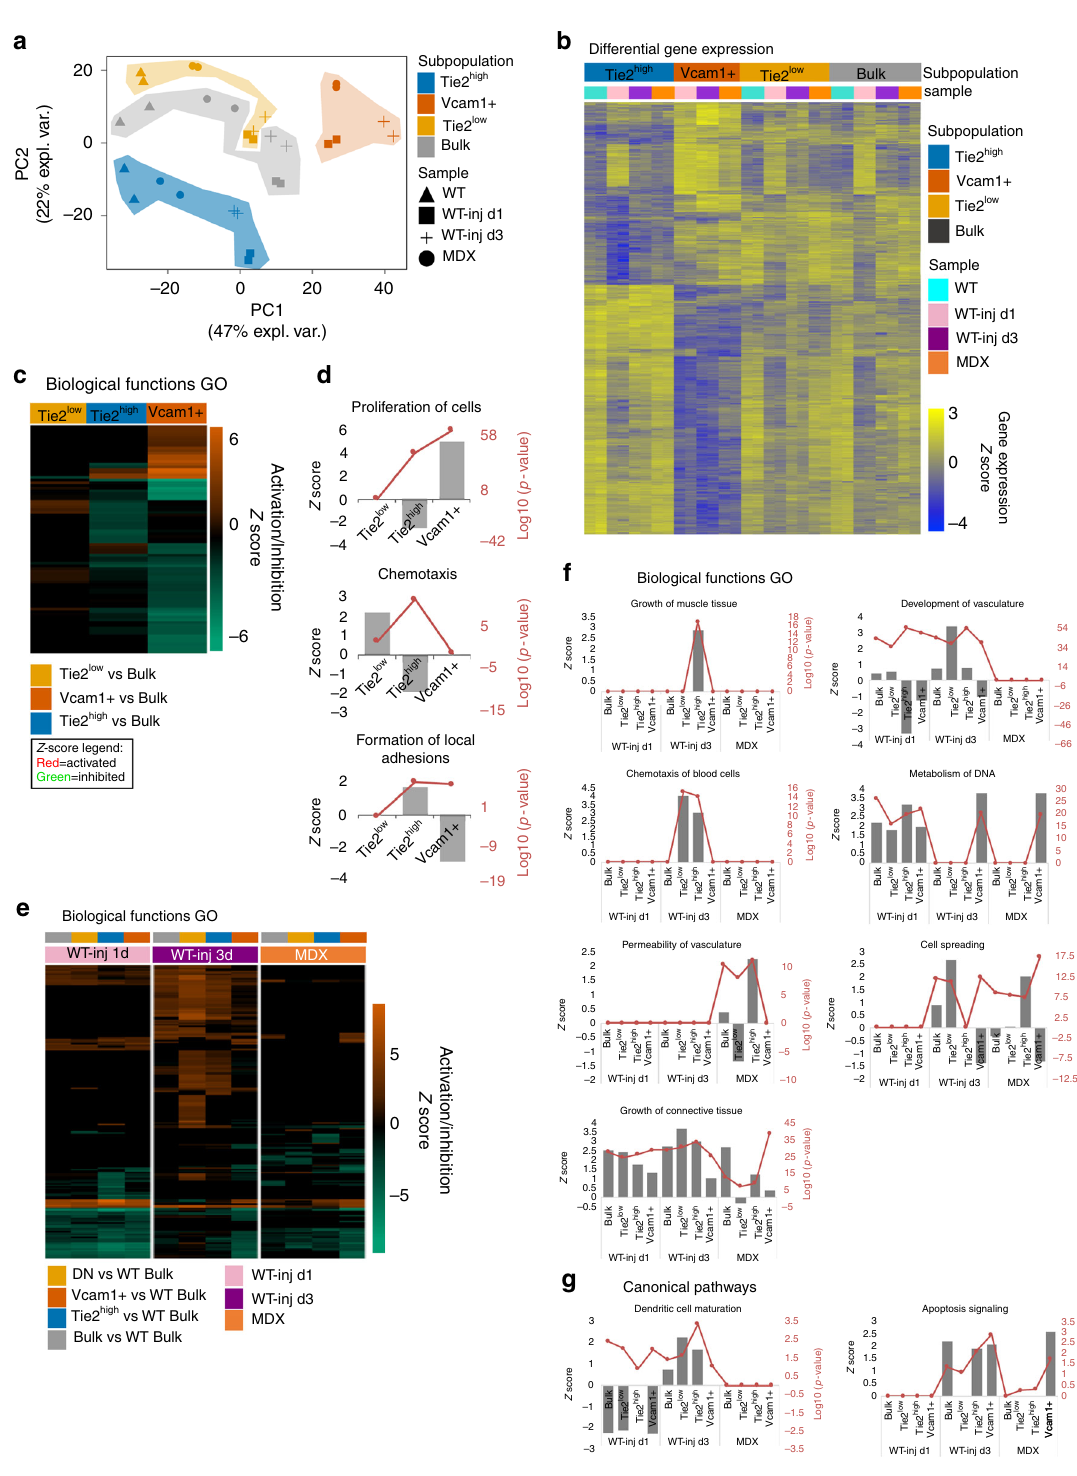
Fig. 3 SubFAPs have unique transcriptional pro fi les that are modulated by injury. a Principal component analysis (PCA) of gene expression data from RNA- seq analysis of FAPs subpopulations isolated from wild type (WT), WT NTX-injured at day 1 and day 3 (WT-inj d1 and d3) and dystrophic mice C57Bl/10 (MDX). b Expression heatmap of genes differentially expressed in FAPs subpopulations (Tie2 high , Tie2 low and Vcam1 + ) compared to bulk FAPs (adjusted p -value <0.001). Gene expression is represented as z -score calculated across the rows. c , d Biological functions predicted to be differentially activated or inhibited in each FAP subpopulation compared to bulk FAPs by IPA comparison analysis. Selected altered functions are shown in d . e , f Biological functions predicted to be differentially activated or inhibited in FAP subpopulations in each treatment condition (WT-inj d1, WT-inj d3 and MDX) compared to bulk WT FAPs by IPA comparison analysis. Selected altered functions are shown in f . g Selected altered canonical pathways in FAP subpopulations in each treatment condition (WT-inj d1, WT-inj d3 and MDX) compared to bulk WT FAPs by IPA comparison analysis. d , f and g Gray bars represent z -score (predicted level of activation/repression of the gene ontology category) with scale on the left. Red lines represent the signi fi cance of the prediction in log10 ( p -value), with scale on the